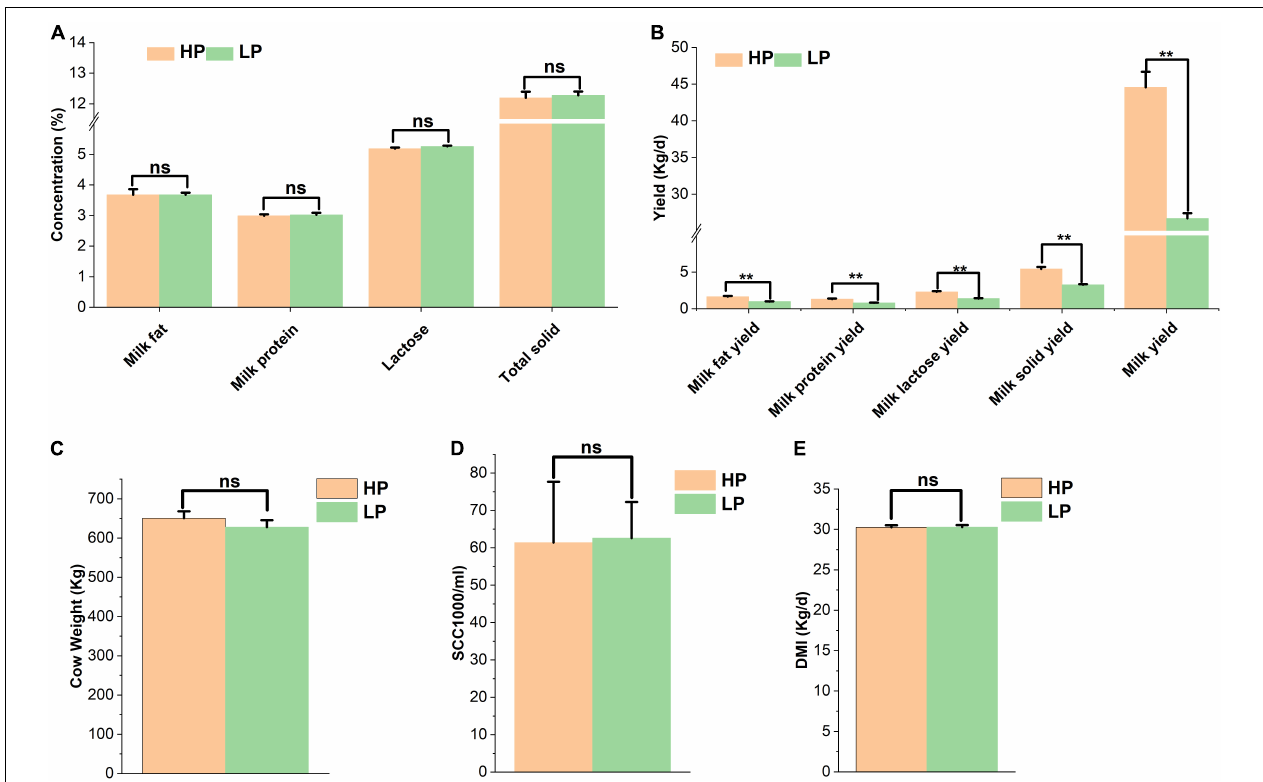
FIGURE 1 | (A) Percentage of milk components of cows in the HP and LP groups. (B) The yield of milk components of cows in the HP and LP groups. (C) Average weight of cows in the HP and LP groups. (D) Somatic cell count in the HP and LP groups. (E) The average DMI of cows in the HP and LP groups. ns: indicates not significant ( p > 0.05), **indicates significant difference ( p <